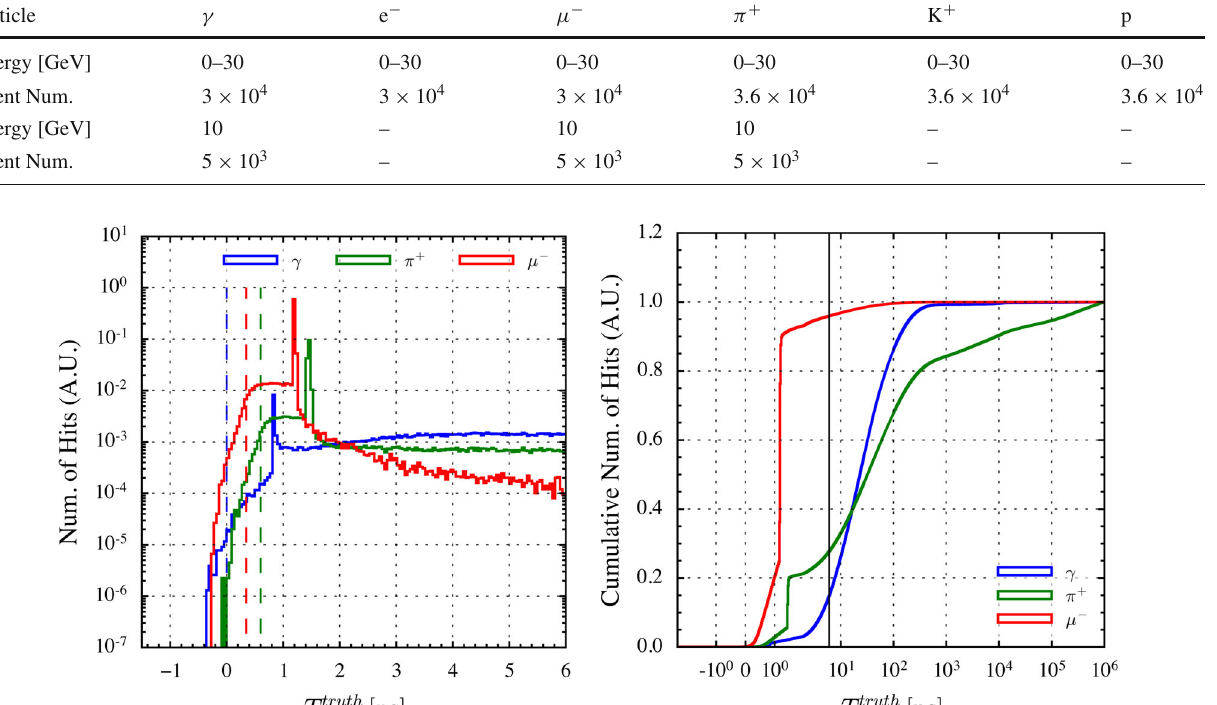
cumulative distribution, the x-axis of the right plot uses a symmetrical logarithmic scale, which is linear in the range of [ − 2 , 2] ps and loga- rithmic in the other region. The total number of all the hits earlier than 1 µ s is normalized to unity in these two plots, which means the integral of the distribution in the left plot equals to the corresponding value in the right